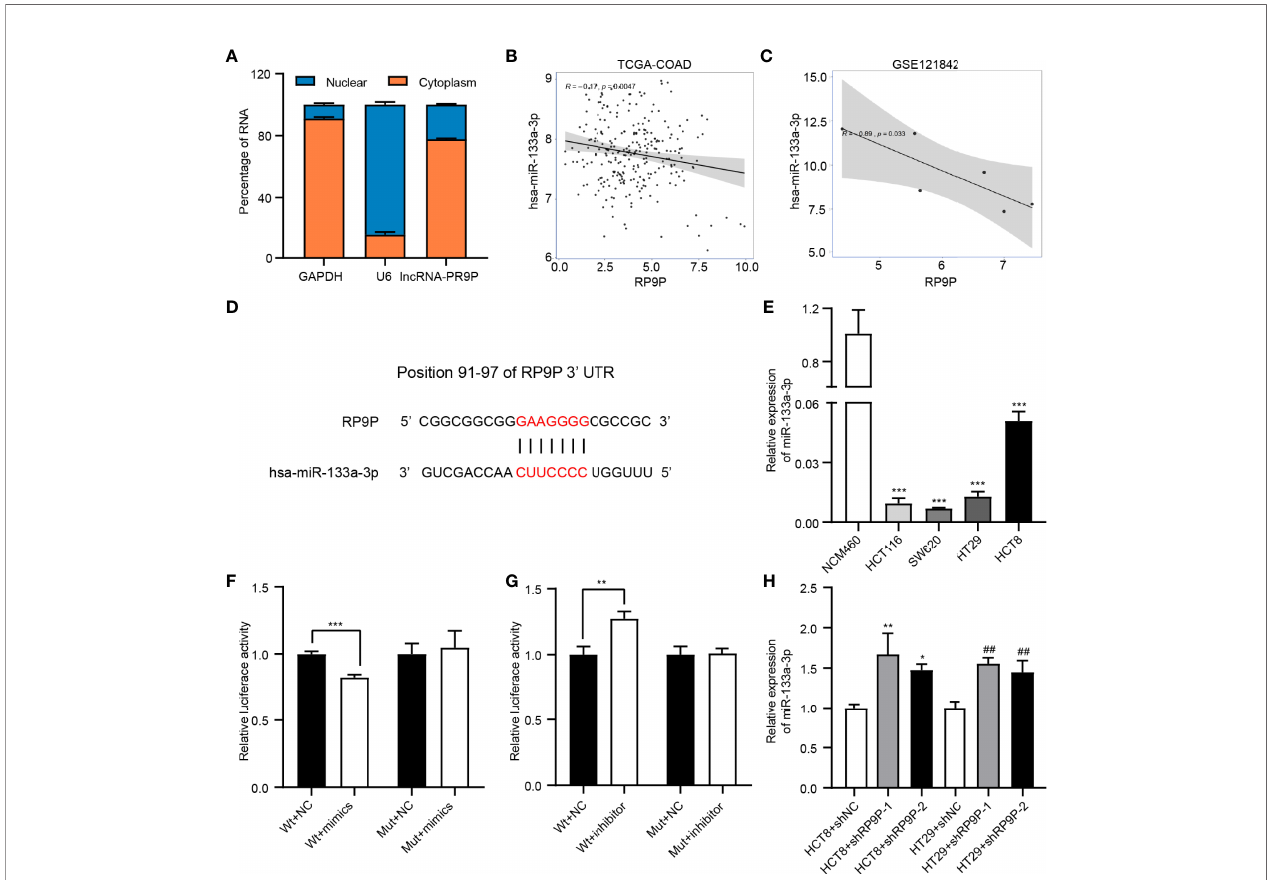
FIGURE 4 | Identi fi cation of miR-133a-3p as a direct target gene of RP9P. (A) Subcellular localization of RP9P in colorectal cancer (CRC) cells. (B, C) The relationship between RP9P and miR-133a-3p was determined using TCGA-COADREAD (B) and GSE121842 (C) data. (D) miR-133a-3p level in CRC cells identi fi ed using real-time (RT)-PCR (*** p < 0.001 vs. NCM460 cells). (E) Predicted binding sites of RP9P and miR-133a-3p and mutated sites in the 3 ′ -untranslated region (UTR) of RP9P. (F, G) Luciferase activity in nonsense control (NC)-, miR-133a-3p mimic- (F) , and miR-133a-3p inhibitor (G) ‐ treated CRC cells with wild-type or mutant RP9P 3 ′ -UTR gene fragments (** p < 0.01, *** p < 0.001). (H) The miR-133a-3p level in CRC cells with RP9P silenced was examined using RT-PCR (* p < 0.05, ** p < 0.01 vs. HCT8 + shNC; ## p < 0.01 vs. HT29 +